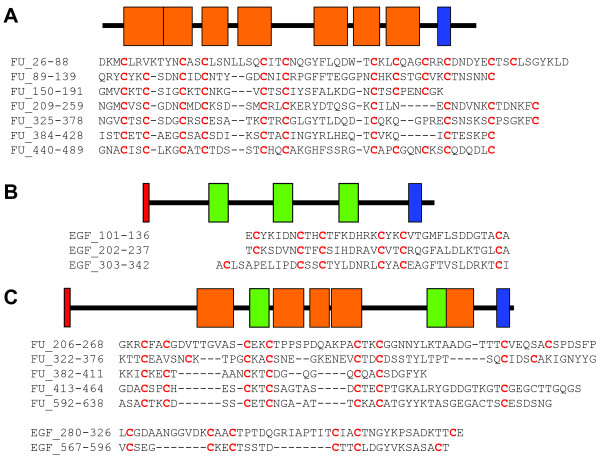
Structural organization of the two identified full-length candidate surface proteins with cysteine rich segments. A: Domain organization of the putative protein encoded by Sp10orf2 (573 residues) [GenBank:DQ812527]. The diagram shows the position of the seven furin-like domains (SM00261 – orange boxes) relative the transmembrane domain (blue box) as determined by SMART4.0 [125]. Several variations were inferred by SMART including some where furin-like domains corresponded to the related EGF-like domain (SM00181 – green boxes, see below). Due to the overlap between these inferences only the furin-like domains are shown for simplicity. The orientation of the protein in the membrane is N-terminus outside and C-terminus inside as inferred by TMHMM2.0 [126]. This is consistent with the hypothesis that cysteine-rich domains are facing the extracellular milieu where they could interact with other proteins. The alignment of the seven inferred furin-like domains as inferred by T-COFFEE [127] is shown below the diagram, with the positions of the first and last residue of each domain indicated on the left. Cysteines are highlighted in red and bold. No putative signal peptide was found with SignalP3.0 [128]. B: Domain organization of the putative protein encoded by Sp1orf4 (453 residues) [GenBank:DQ812518]. This protein has a similar structural organization as the one shown in A with three EGF-like domains inferred to face the external milieu. The three EGF-like domains were aligned manually. In addition, this sequence may have a signal peptide (indicated by a red box) since the S-score is positive in SignalP3.0 [128]. C: Domain organization of G. lamblia VSP417-6 protein (704 residues) [GenBank:AAF02907] [129] is shown for comparison. Four furin-like and two EGF-like domains identified by SMART4.0 [125] were aligned with T-COFFEE [127]. The G. lamblia sequence possesses a signal peptide according to SignalP3.0 [128]. All diagrams are drawn to scale.